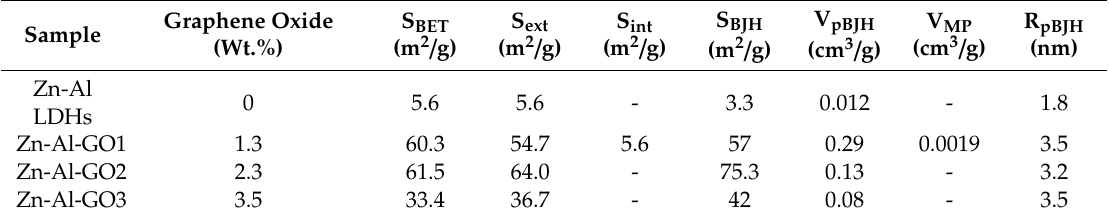
Table 1. Adsorption data derived from adsorption–desorption isotherms for Zn-Al LDHs before and after combining with graphene oxide using Brunauer − Emmett − Teller (BET), de Boer and Barrett − Joyner − Halenda (BJH) methods.